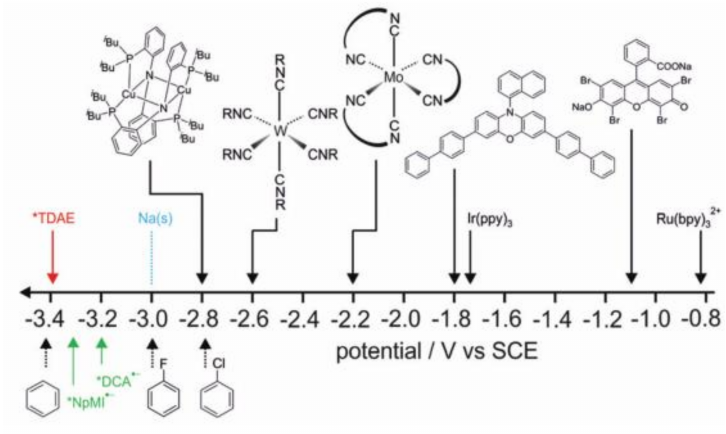
Figure 11. Proposed mechanism for the C-H carboxylation of (hetero)arenes with TMAH as the photosensitizer. Reprinted with permission from Ref. [48]. Copyright 2020, Elsevier Inc.